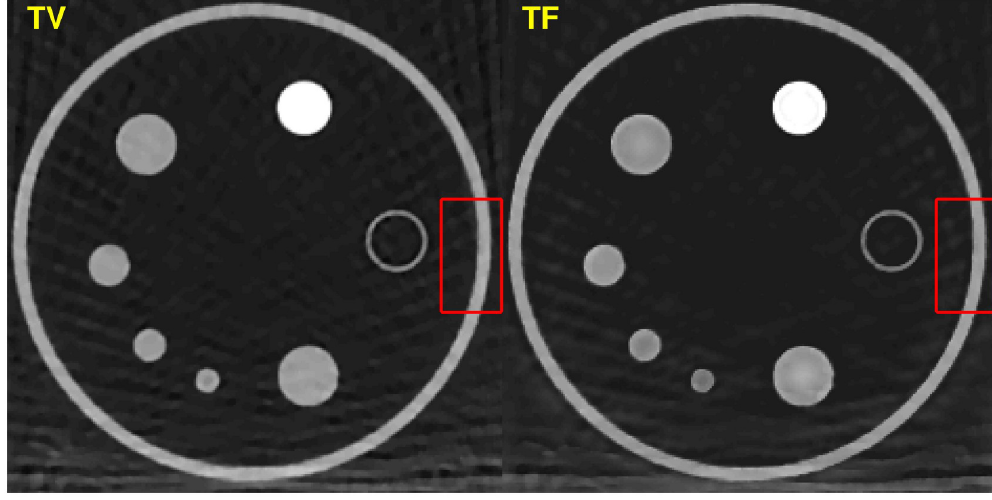
Fig 12. Visual quality comparison: TV(left) and TF(right). TF image has less streaking artifact. As shown in the red box, TF maintain sharpen